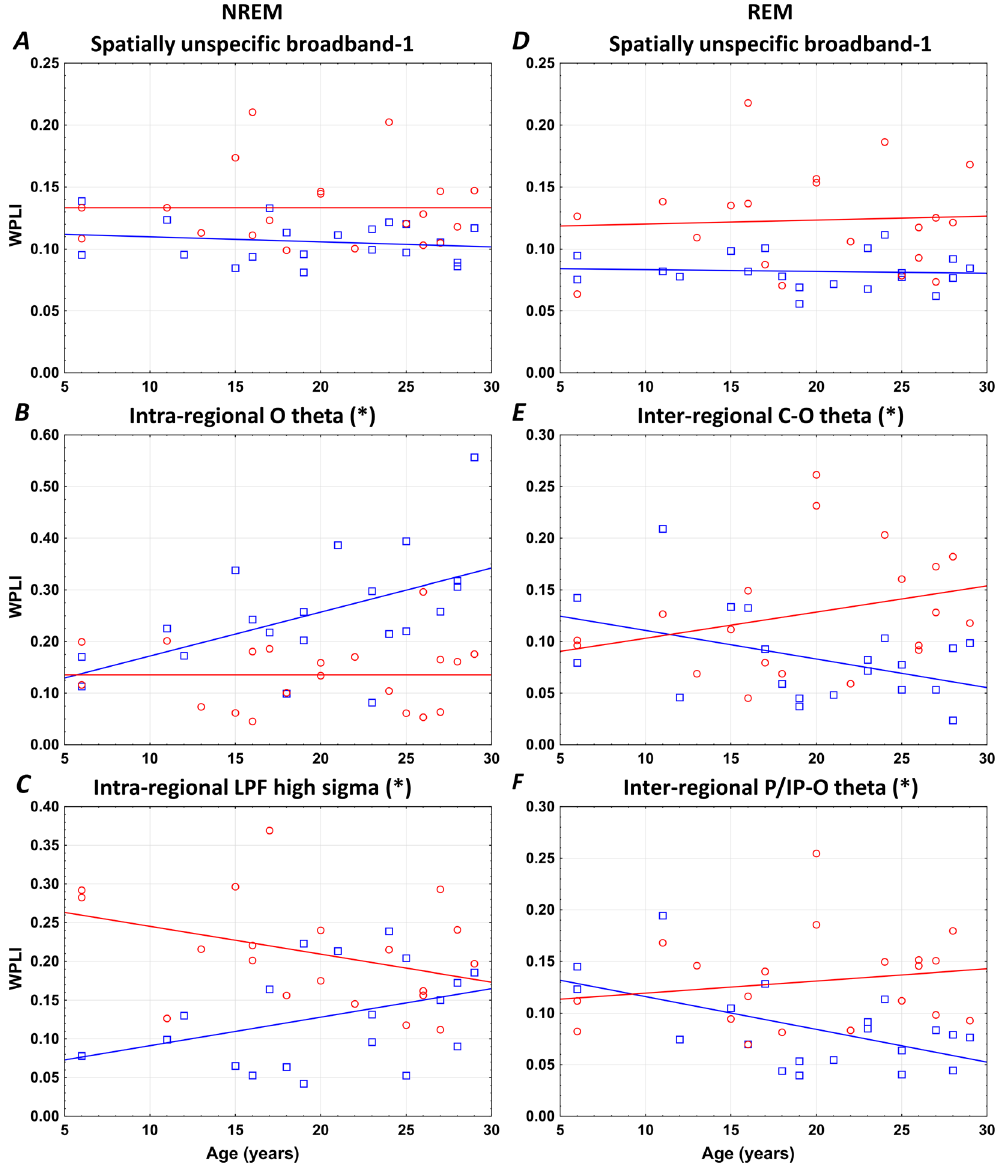
Figure 7. Developmental trajectories of neural connectivity. ( * ) Denotes significant age × group effects based on homogeneity of slopes analysis indicating altered developmental patterns of sleep-related neural connectivity in Williams syndrome. Left column: NREM sleep, right column: REM sleep. Color codes: Red = Williams syndrome, blue = typically developing. ( A and D ) are examples of the 131 age-independent Williams syndrome vs. typically developing group differences in sleep EEG WPLI values. ( B and C ) Show the lack of an age- dependent increase in NREM sleep EEG connectivity (intra-area O theta and intra-area LPF high sigma), while ( E and F ) reflect the lack of any age-related decrease in REM sleep neural connectivity (inter-area C-O and P/ IP-O theta) in Williams syndrome